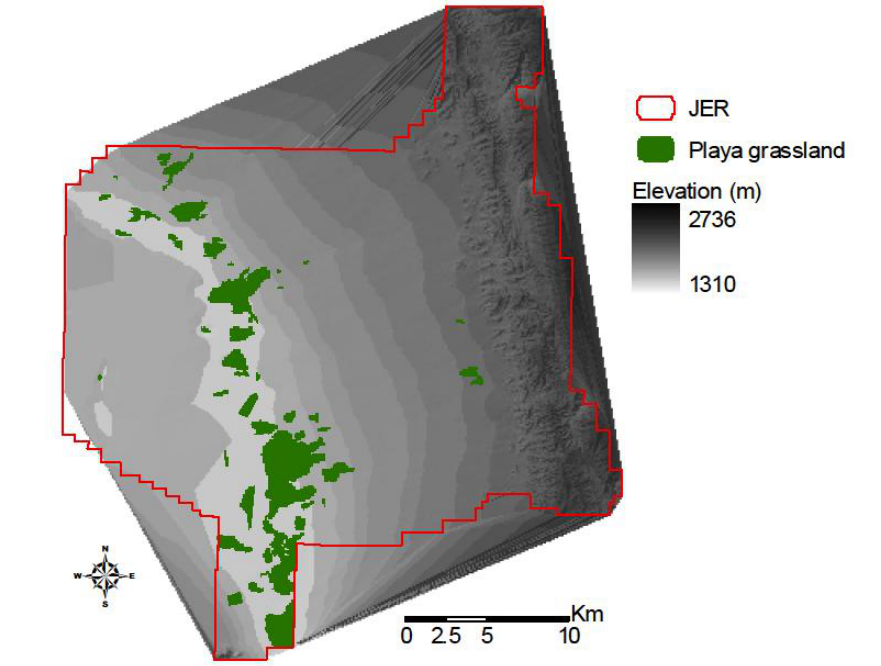
Figure 7. TIN from contours. Playa grassland is located at the lowest elevation of the area.